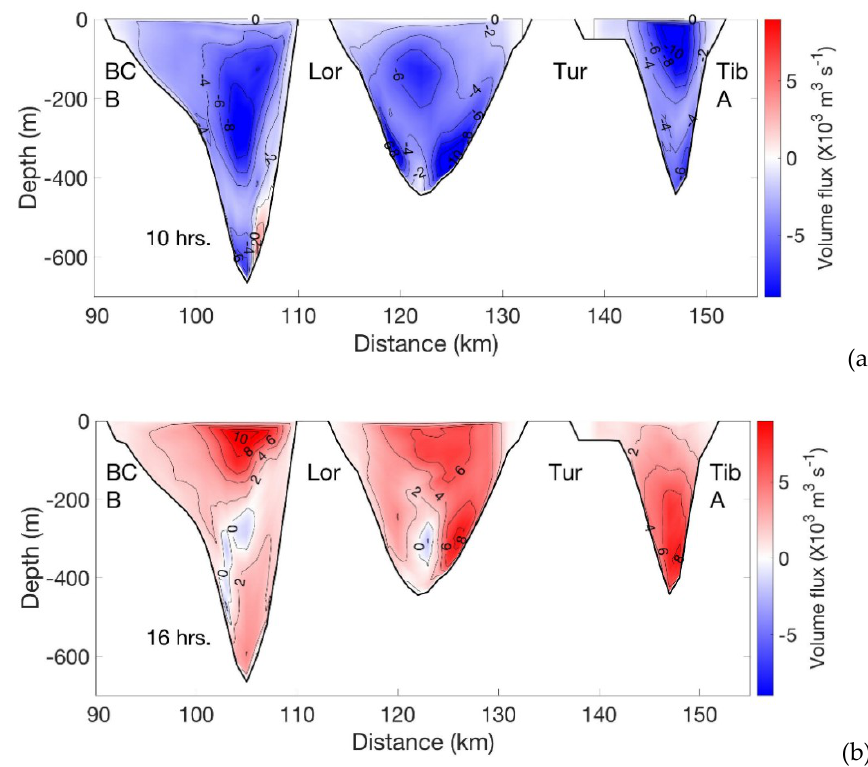
Figure 6. Same as Figure 5 but of the volumetric flux (Q) for (a) inflow and (b) outflow.